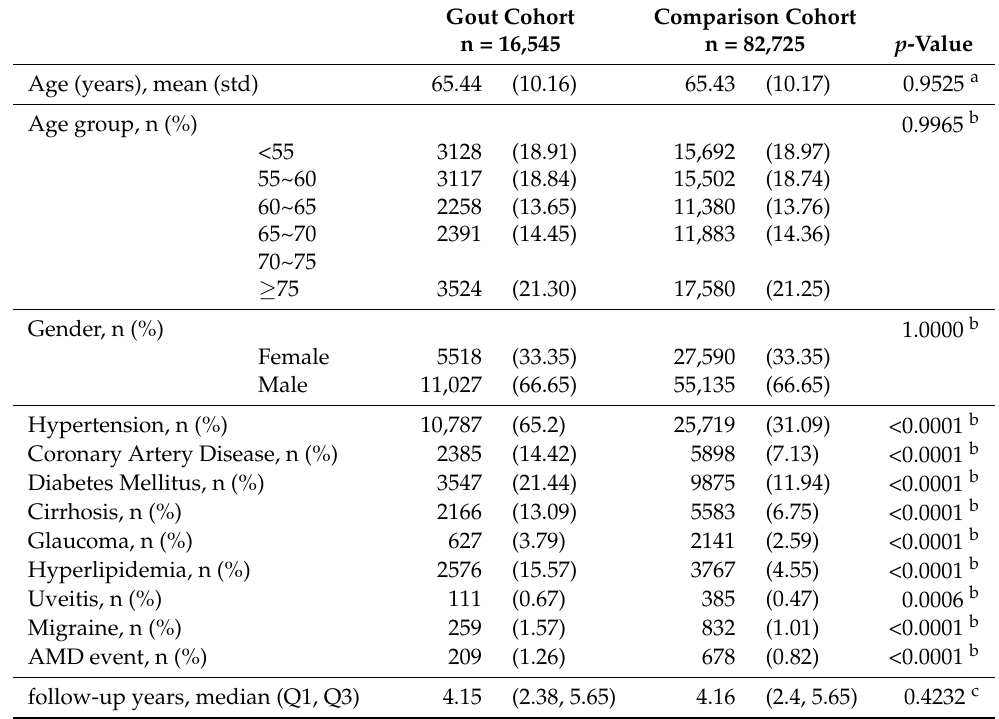
Table 1. Baseline characteristics after matching with age and gender.